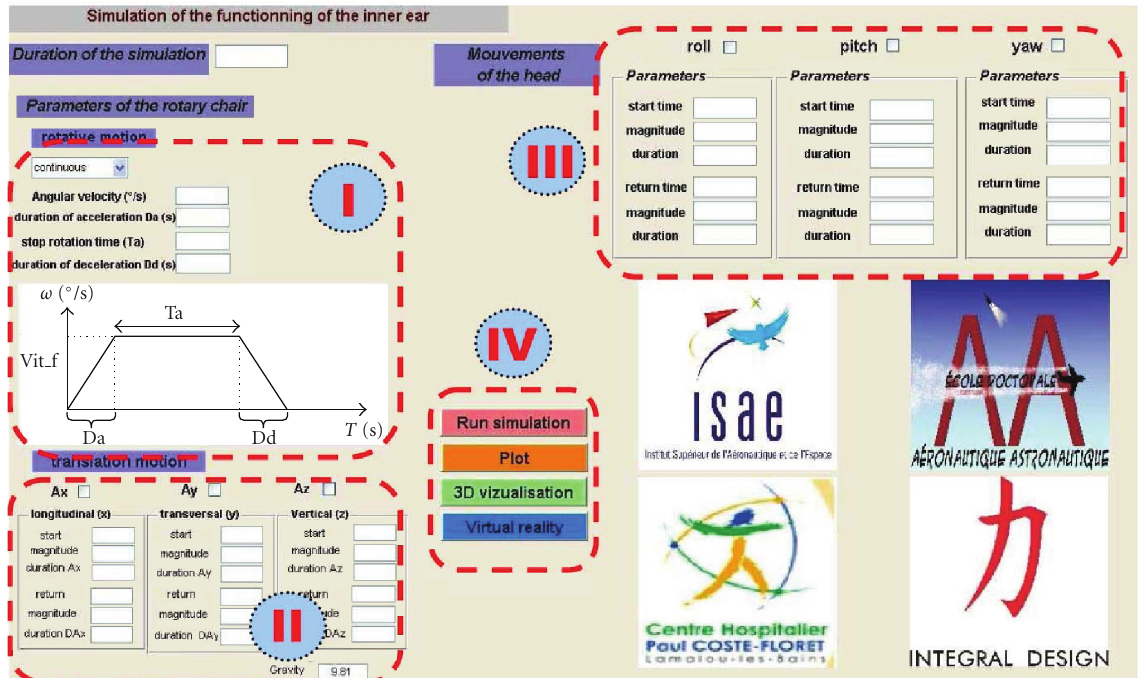
Figure 6: Graphical user interface. I:parameters of the rotary chair; II:parameters of exterior linear accelerations; III:parameters of head movements; IV:simulation, results and virtual reality push buttons.